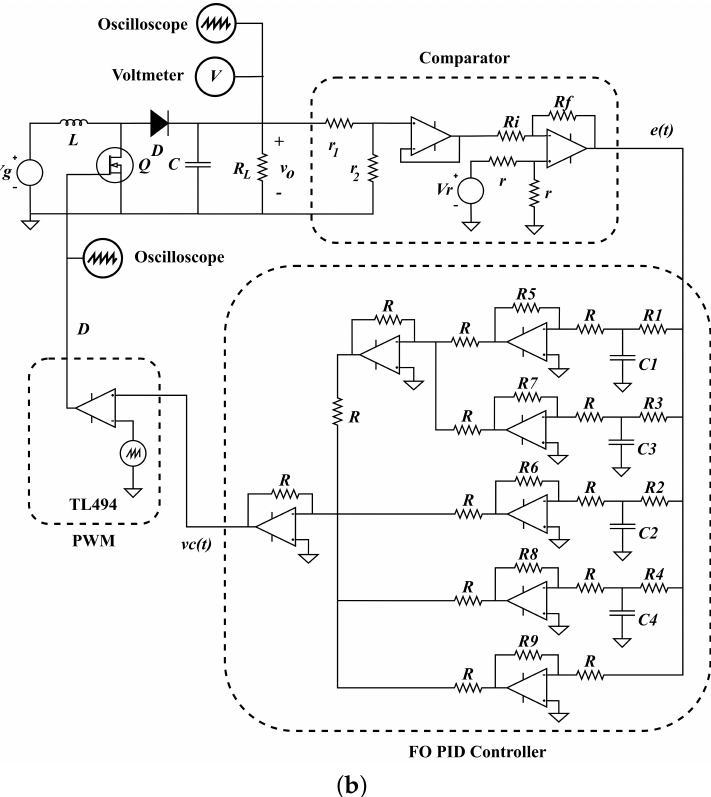
Figure 9. ( a ) Worktable with the implementation of the non-integer order PID controller approxima- tion. ( b ) Electrical representation of the experiment of voltage regulation in a boost converter.